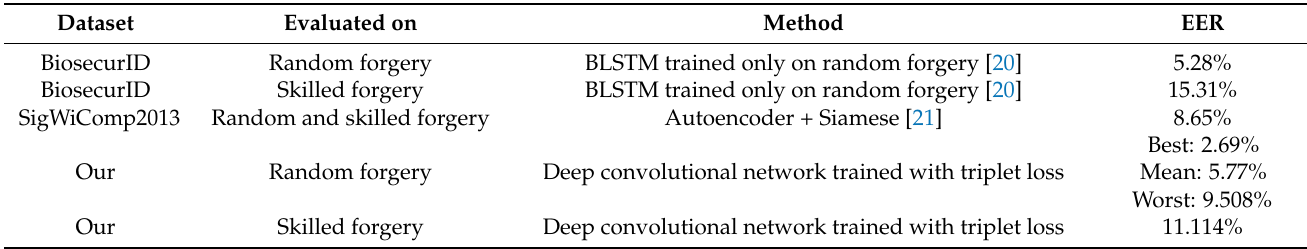
Table 2. Evaluation results obtained on various datasets by state-of-the-art methods in comparison to results for our method.